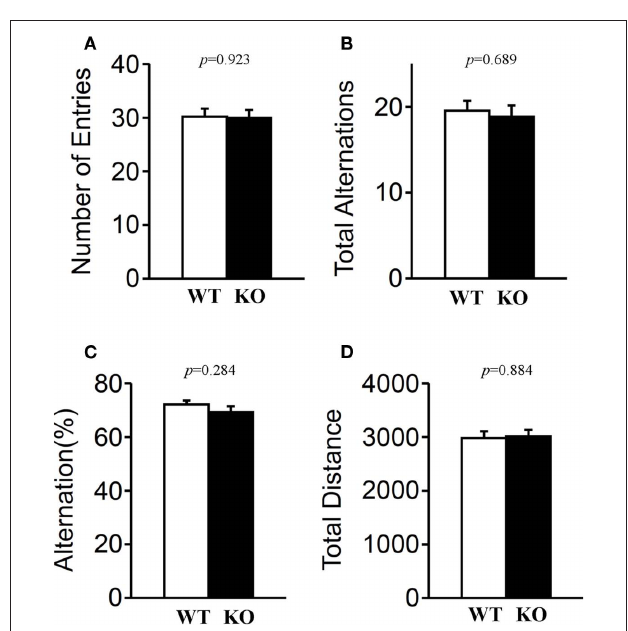
Figure 11 | Y-maze test. Mice ( n = 20 each) were individually placed into a symmetrical Y-maze. Total number of arm entries (A) , number (B) and percentage (C) of alternation between Y-maze arms, and total distance (D) were recorded. Data presented as mean ± SEM. p -Values were calculated by Student’s